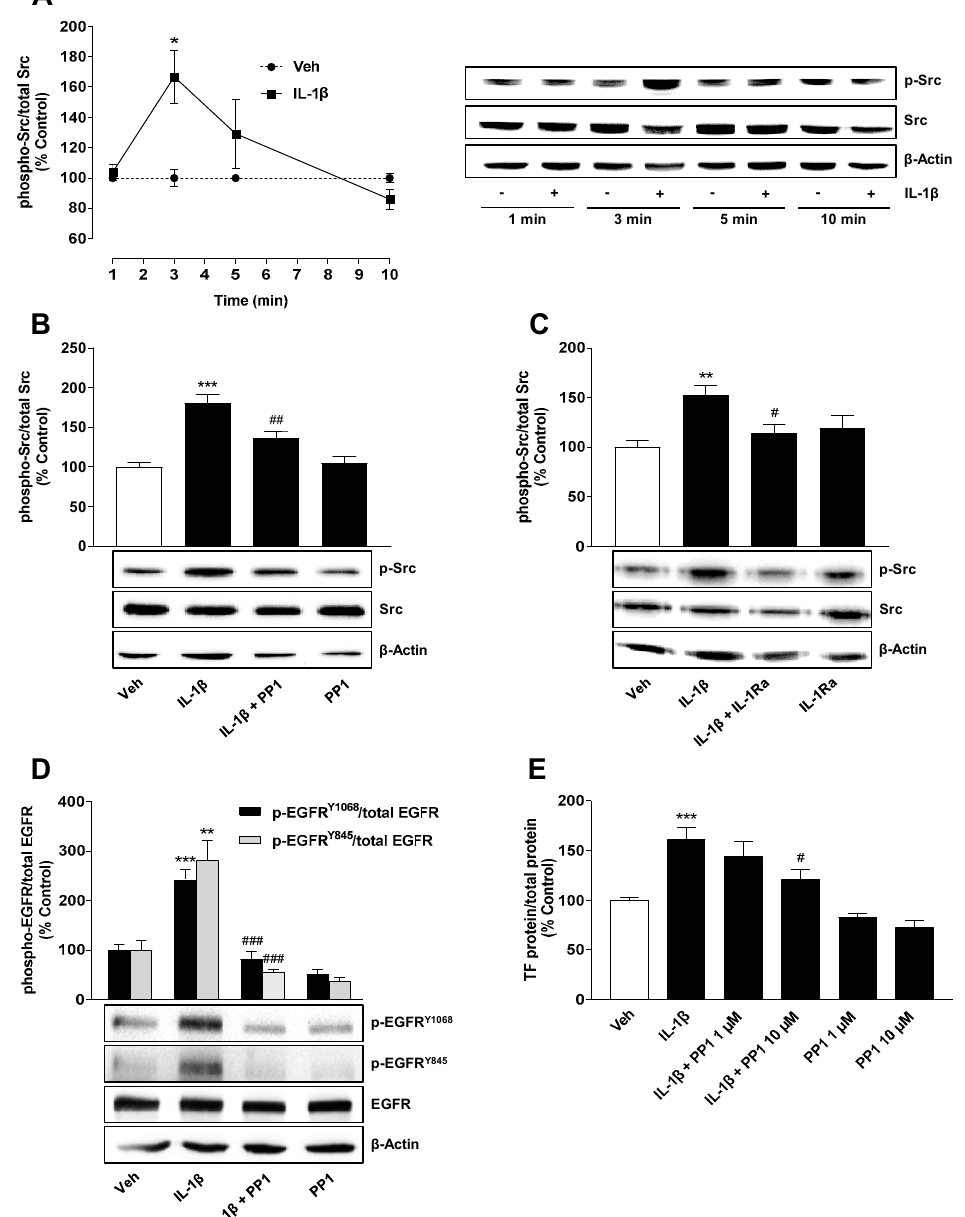
Figure 5. Src phosphorylation induced by IL-1 β confers EGFR activation and subsequent TF expression. Time course of IL-1 β -induced activation of Src ( A ). Effect of the Src inhibitor PP1 ( B ) and IL-1Ra ( C ) on IL-1 β -induced Src activation. Impact of PP1 on EGFR activation at Tyr1068 and Tyr845 ( D ) and TF protein formation ( E ). The cells were incubated in the presence or absence of IL-1 β (10 ng/mL) for the specified time periods ( A ), 3 min ( B , C ), 10 min ( D ) or 6 h ( E ). The cells were preincubated with PP1 for 1 h at 10 µM ( B , D ) or at the indicated concentrations ( E ). In case of IL-1Ra ( C ), cells were incubated with the receptor antagonist at 10 µg/mL for 2 h and then coincubated with IL-1 β or vehicle for the times indicated above. All percentage values shown refer to the respective vehicle control, which was set to 100%. The values shown in the graphs A – D are based on densitometric analyses of blots, whereby the phosphorylated forms were normalized to the respective total form. In the labelling of the Src ( A , B , C ) and EGFR blots ( D ) as well as in the legend ( D ), the prefix "p-" stands for "phospho-". The blots shown are representative. All data are mean values ± SEM of n = 3 ( A ), n = 5 ( B ), n = 7 ( C ), n = 3 ( D , p-EGFR Y845 ), n = 4 ( D , p-EGFR Y1068 ) or n = 7–8 ( E ) experiments per group. * p ≤ 0.05, ** p ≤ 0.01, *** p ≤ 0.001 vs. vehicle control; # p ≤ 0.05, ## p ≤ 0.01, ### p ≤ 0.001 vs. IL-1 β ; Student’s t test ( A ) or one-way ANOVA with Bonferroni’s post hoc test ( B – E ).